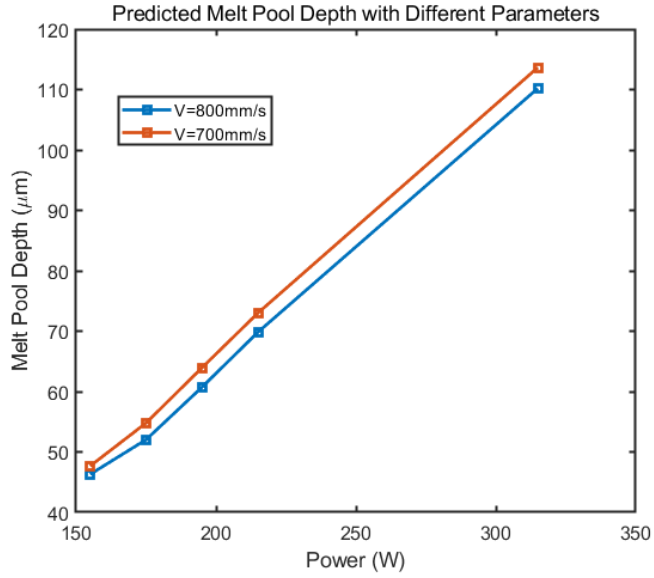
Figure 7. Predicted melt pool depth with different assumed power. The layer thickness 30 µ m, and hatching space 0.17 mm.